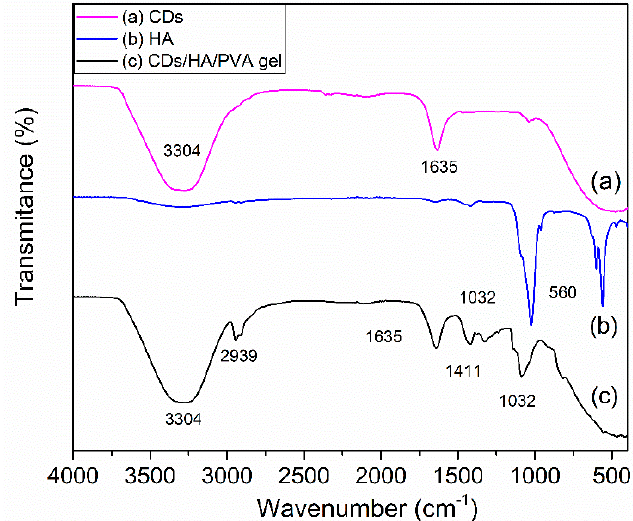
Figure 1. The FTIR spectra of dried ( a ) CDs powder, ( b ) HA powder, and ( c ) CDs / HA / PVA hydrogel.